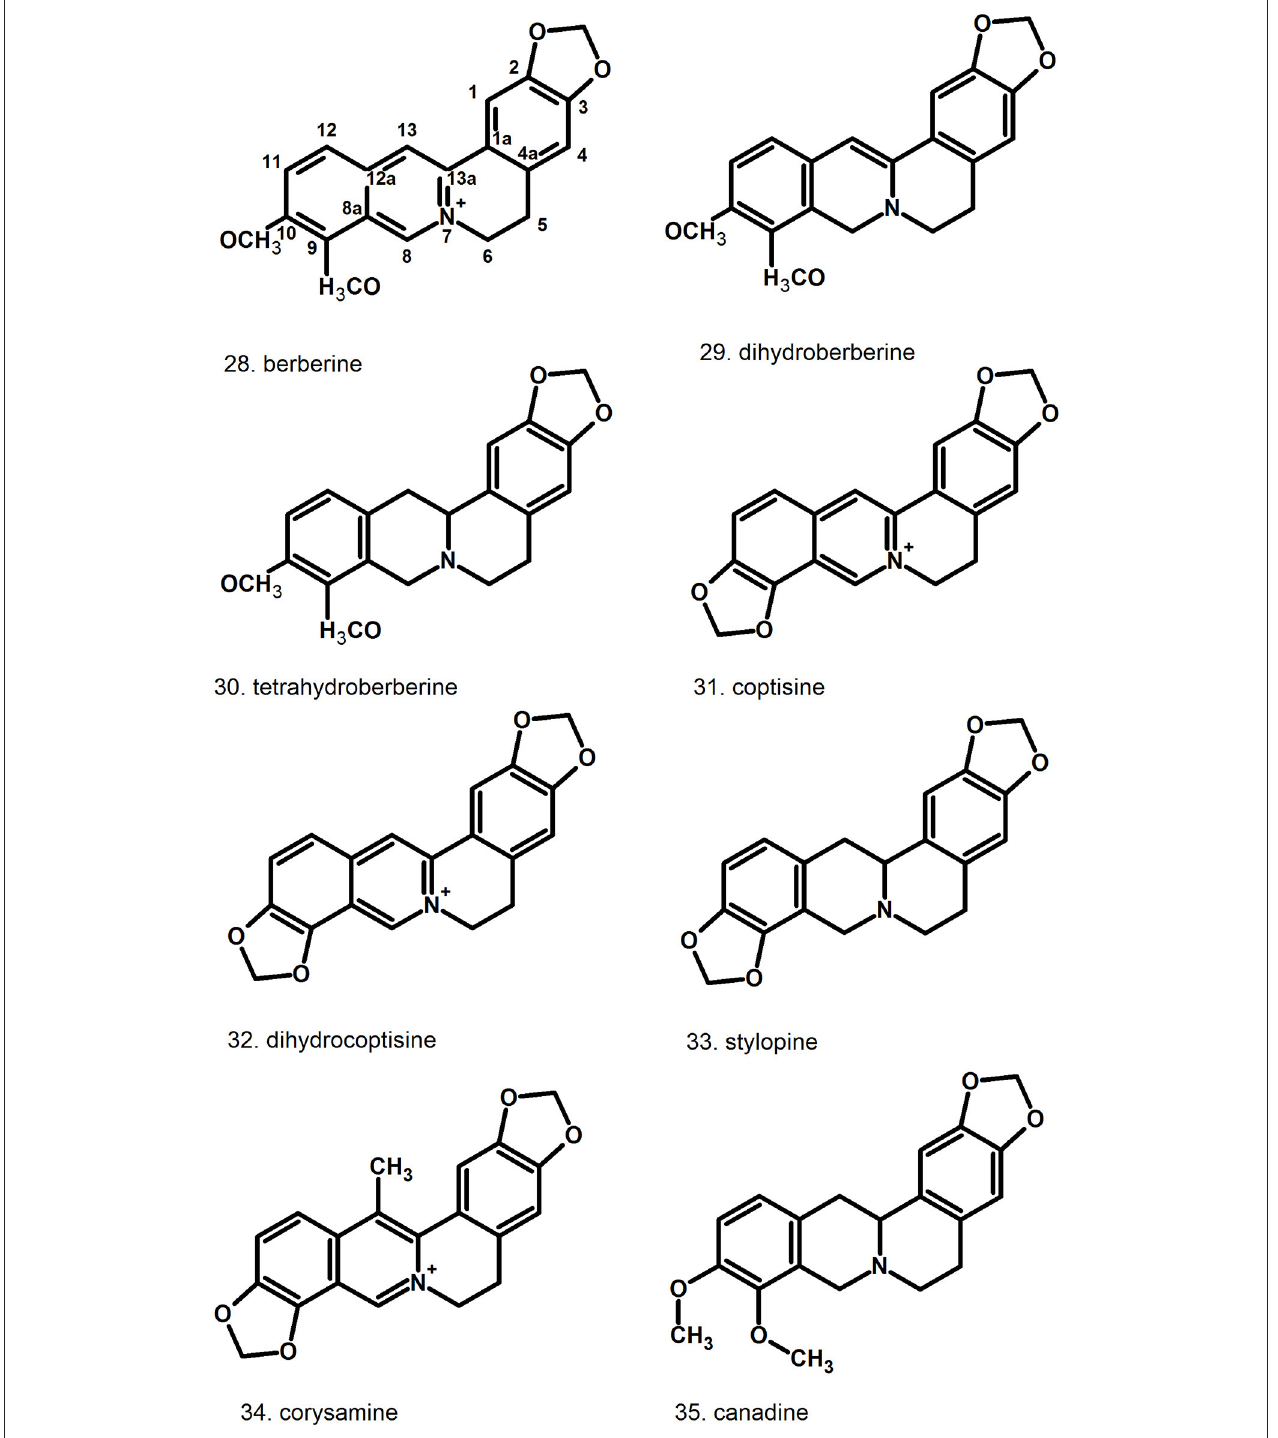
FIGURE 5 | Structures of protoberberine